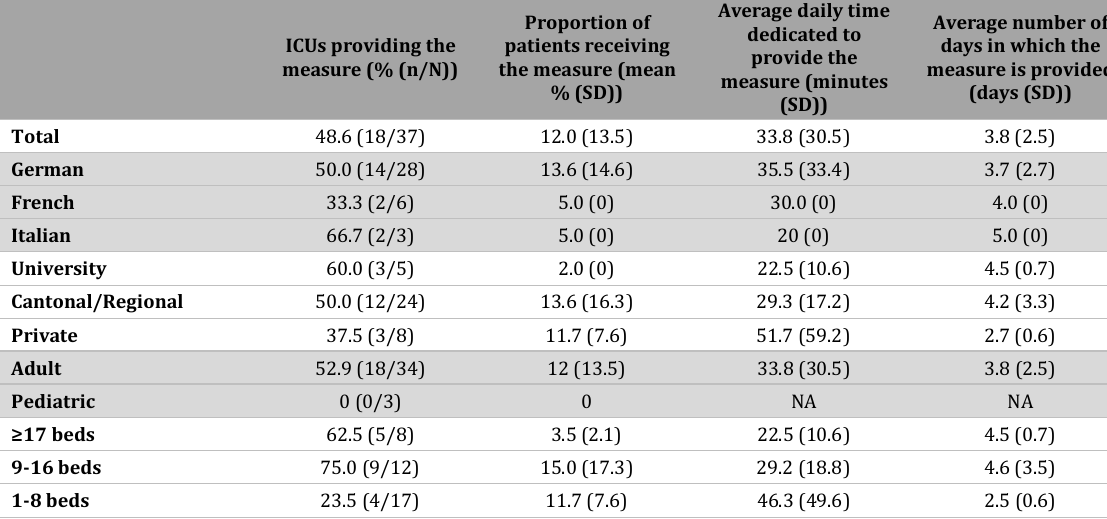
Table S8. Passive cycling in bed